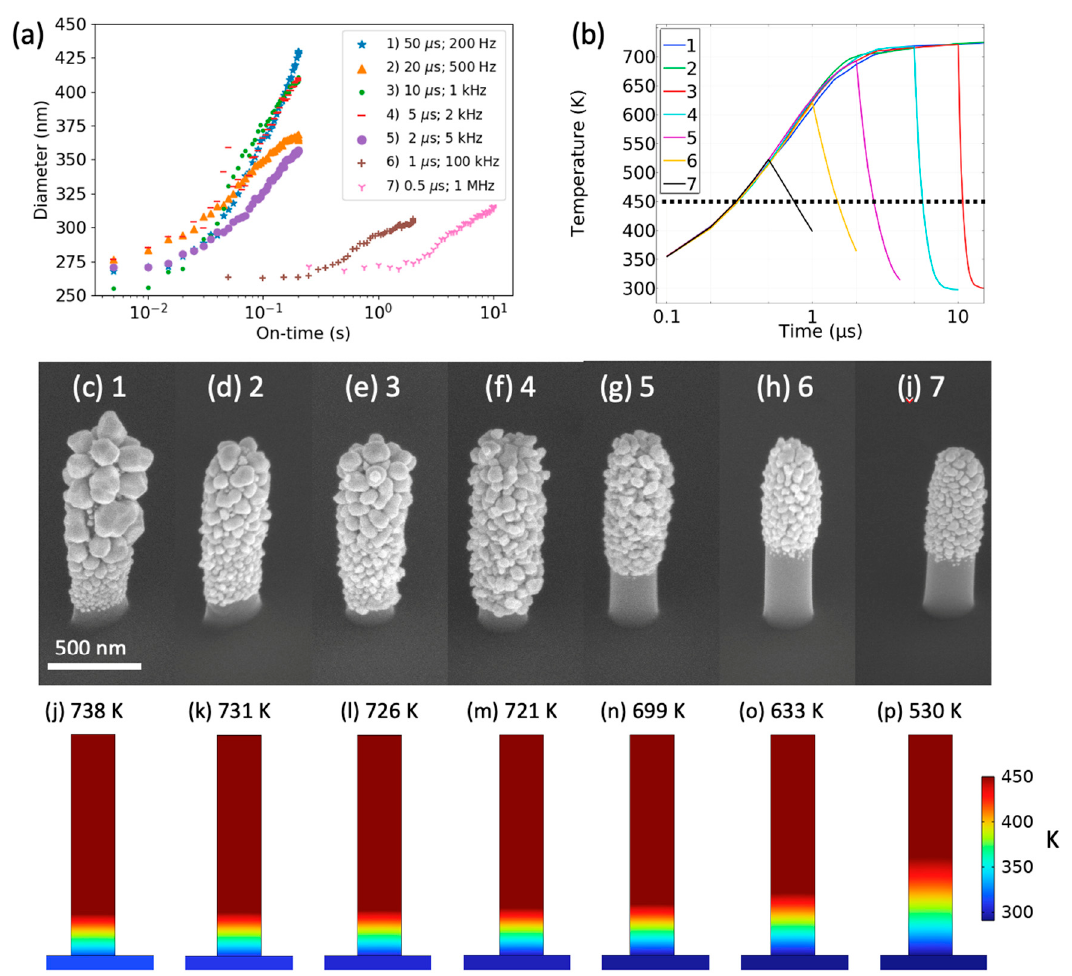
Figure 4. ( a ) A plot of the nanopillar diameters as a function of laser on-time at different pulse widths. ( b ) The simulated time versus temperature focused on 0.5, 1, 2, 5 and 10 µs pulse widths, as longer pulse widths have similar profiles to 10 µs. ( c – i ) SEM images of the nanopillar after processing at different pulse widths. ( j – p ) Modeled temperature profiles of the nanopillars at the end of the specified laser pulse width and peak temperature listed above the nanopillar.